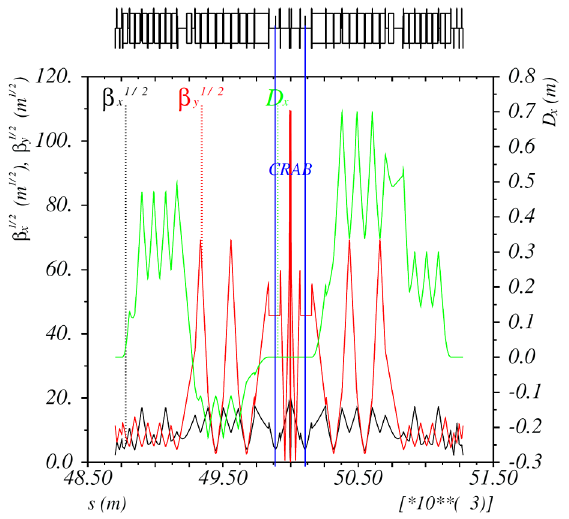
FIG. 16. Optical functions of FCC-ee interaction region variant